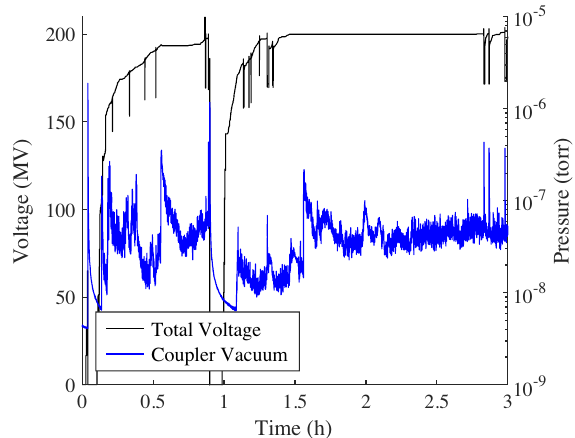
FIG. 18. Cryomodule voltage (top) and coupler vacuum level (bottom) verses time. Vacuum spikes that exceed the trip level (dashed line) shut off rf power to all cavities.